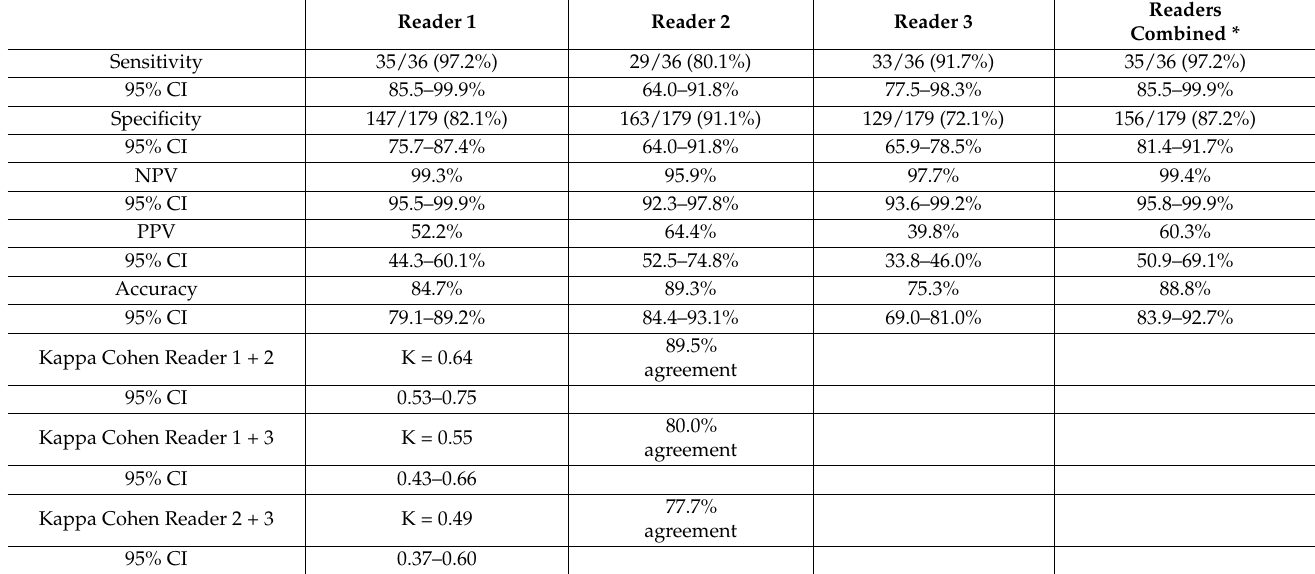
Table 2. Scoring results of the three readers (separate and combined using majority vote) in subgroups with and without HCC in a surveillance population, with statistical analysis.